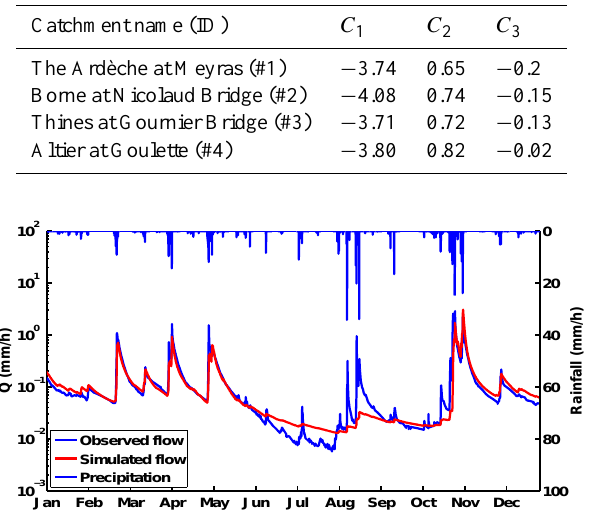
Figure 6. Series of simulated hourly hydrographs (red) for the Ardèche at Meyras (#1) catchment for the year 2004, compared with observed discharge (blue).